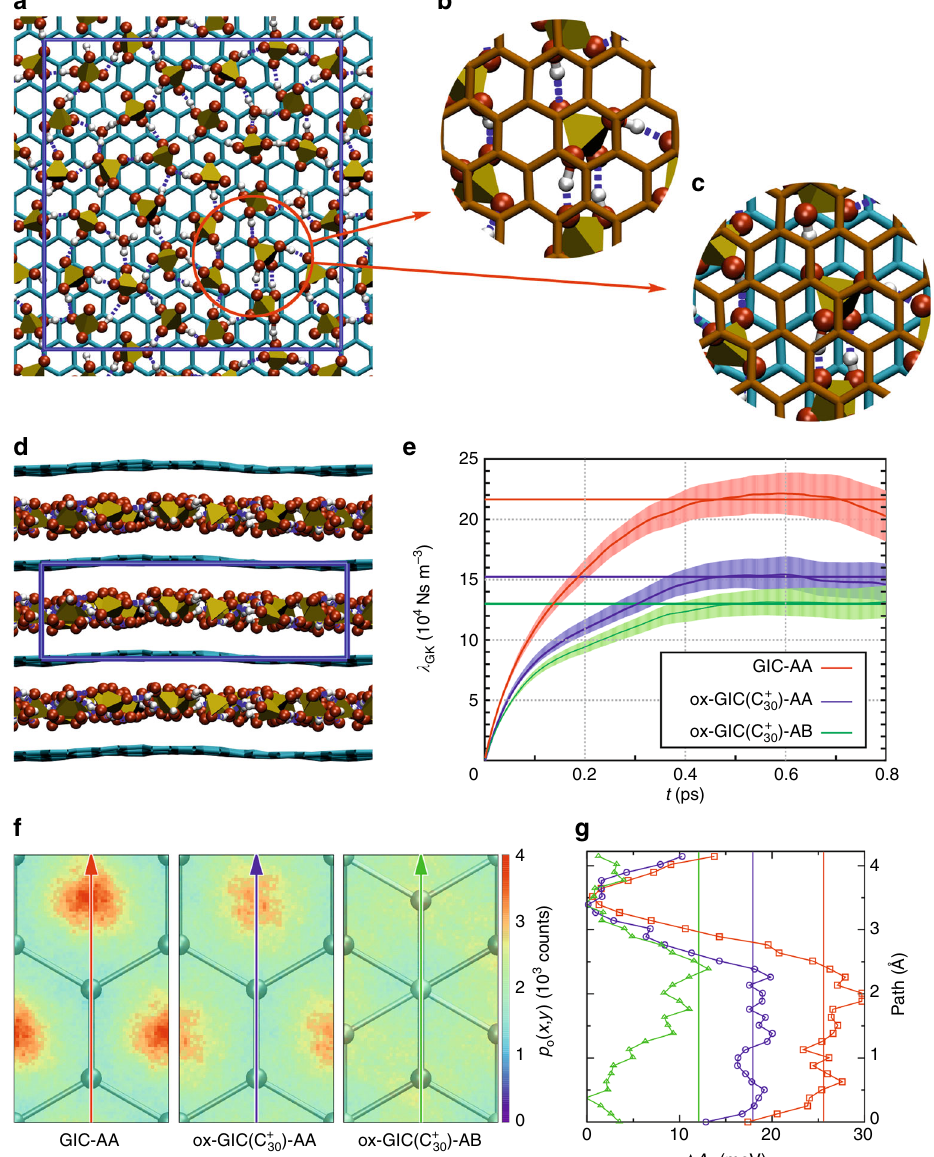
)-AA supercell. b , c Enlargement of the top view including a second Fig. 6 Molecular dynamics simulations. a , d Top and side view of the ox-GIC( C þ 30 graphene layer (brown) for the ox-GIC( C þ )-AA and the ox-GIC( C þ )-AB simulation. Turquoise and brown: carbon framework, yellow: sulfate tetrahedron, 30 30 red: oxygen atoms, gray: hydrogen atoms, blue: simulation box. e Green-Kubo friction coef fi cient as function of simulation time. Shaded areas: error bars represent standard error of the mean as obtained from block averaging. New starting points were set every 1000 MD time steps (see Supplementary Note 3). f Probability distribution map of oxygen atoms (same z -scale for all sub fi gures) mapped on a single orthorhombic unit cell. g Line scan through oxygen distribution map along the red, blue and green